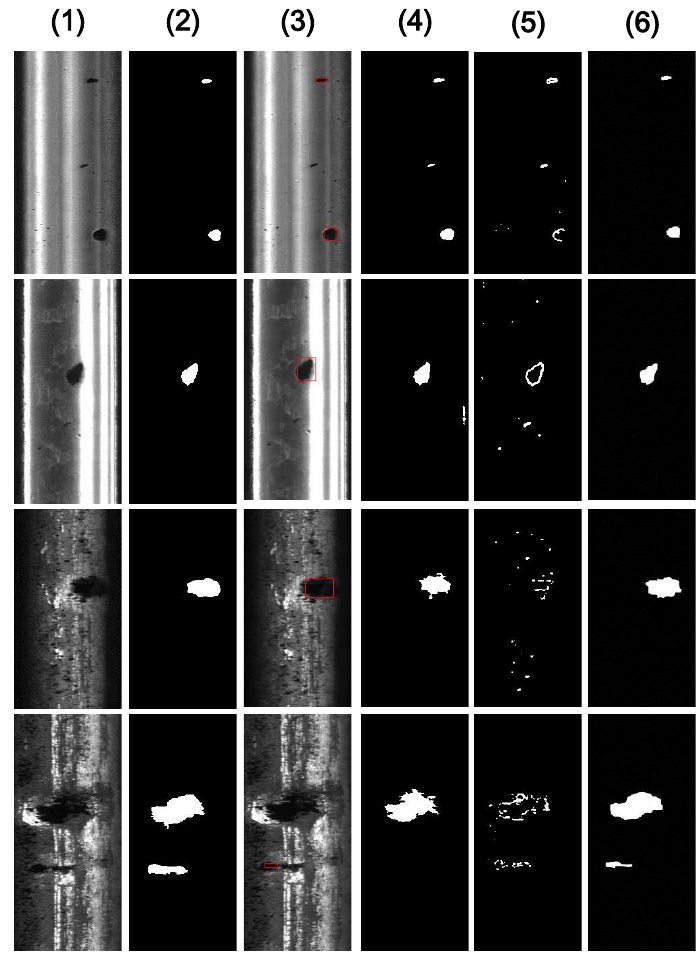
Figure 7. Sample defect images and inspection results for different methods from the Type-I RS-